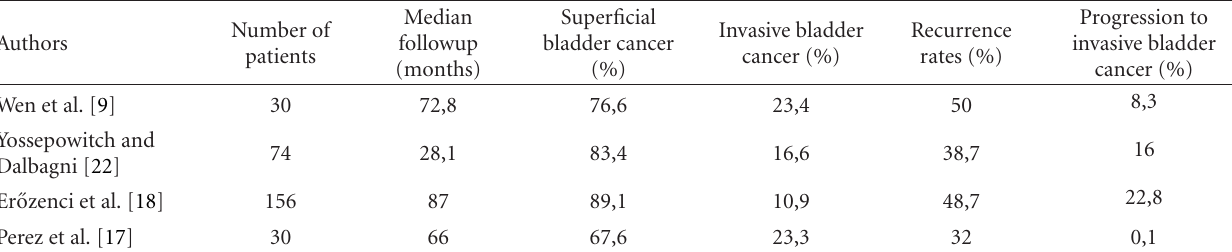
Table 2: Comparative data of young patients with bladder cancer from other